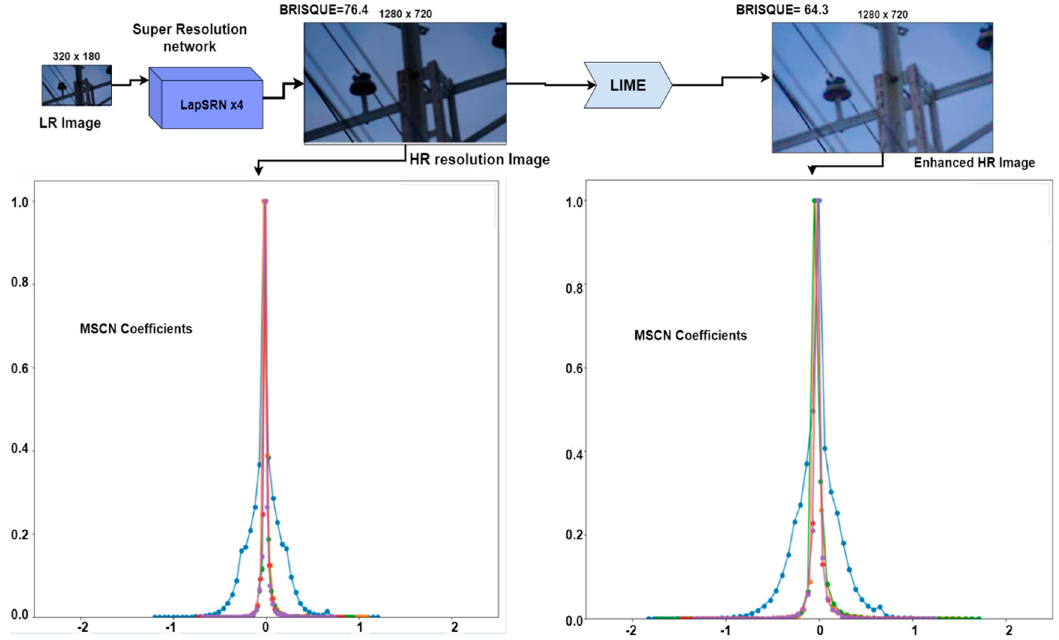
Figure 15. Improvement steps of specific insulator training dataset by LapSRN and LIME.